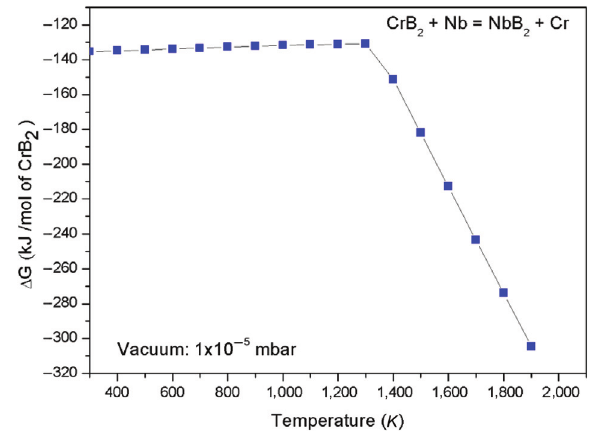
Figure 4 : Free energy change for reaction between CrB 2 and Niobium (calculated using FactSage